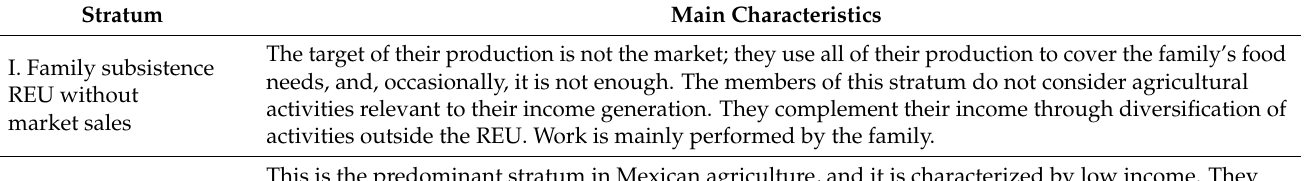
Table 5. Stratification of the Rural Economic Units (REUs) used in this study. Main Characteristics